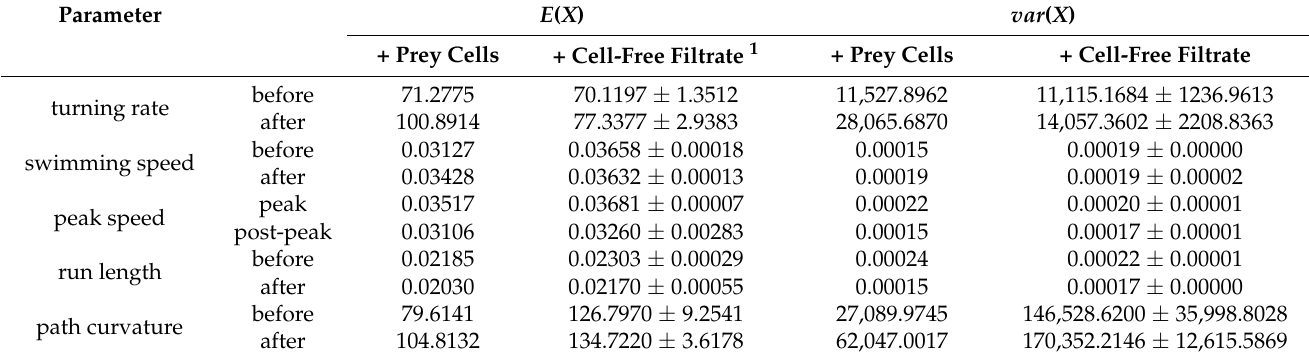
Table 2. Expected values and variances based on the parameters in Table